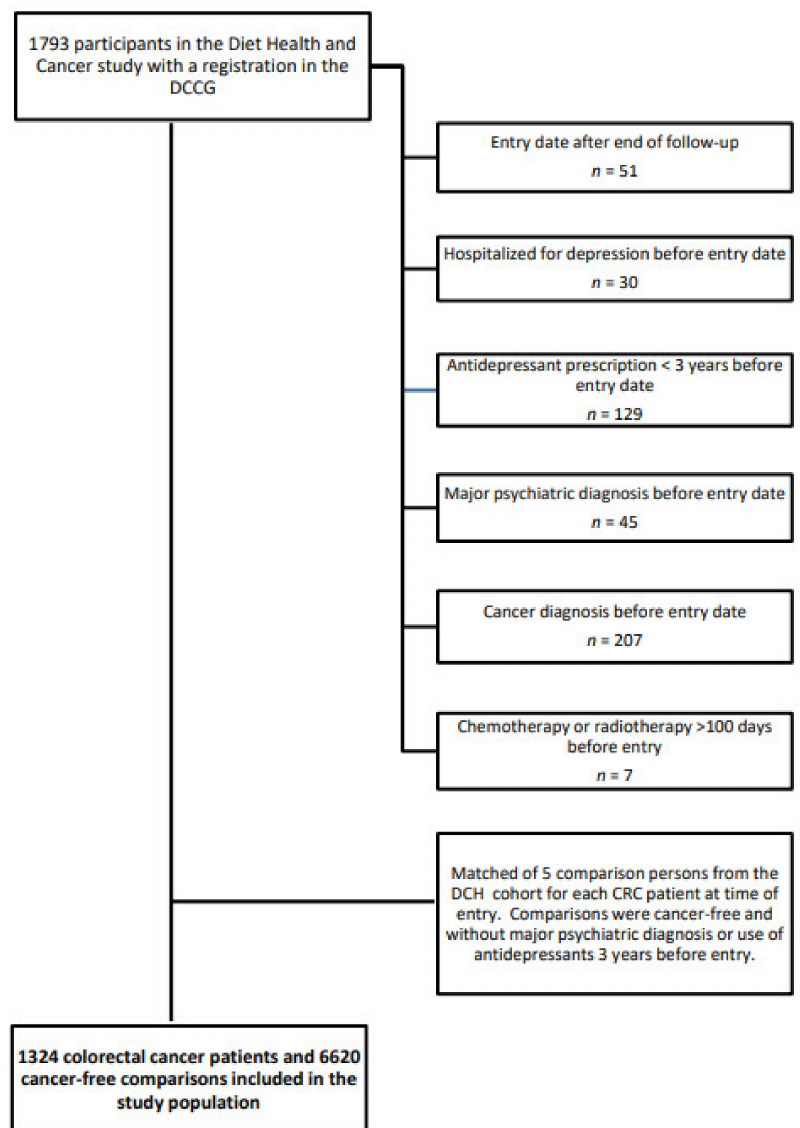
Figure 1. Flowchart of the formation of the study population of 1324 colorectal cancer patients and 6620 cancer-free comparison persons who participated in the Diet, Cancer and Health study,